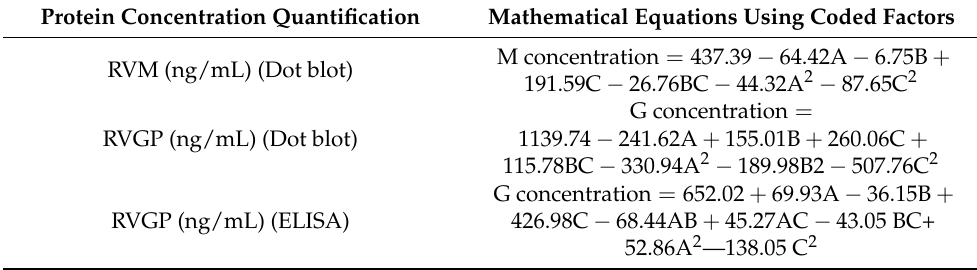
Table 3. Summary of adjusted statistical quadratic models in coded factors (range of − 1 to +1) for protein concentrations by dot blot and ELISA derived from overall experimental design including all co-infection experiments, namely, 1, 2, and 3 (Table 1). The critical parameters assessed were BVM MOI (A), BVG/BVM MOI ratio (B), and HT (C). The adjusted quadratic models and terms included in them were statistically significant ( p <